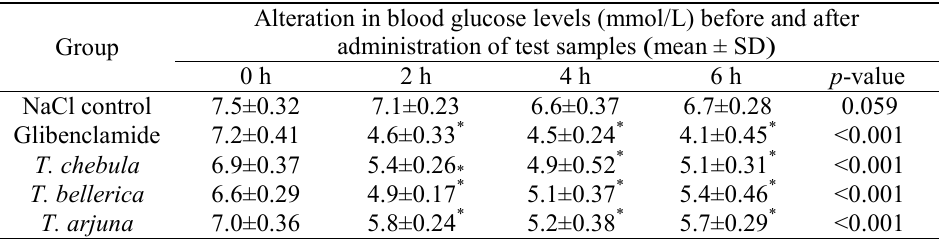
Table 3. Hypoglycemic activity of methanolic leaf extracts by oral route in normal rats. Group